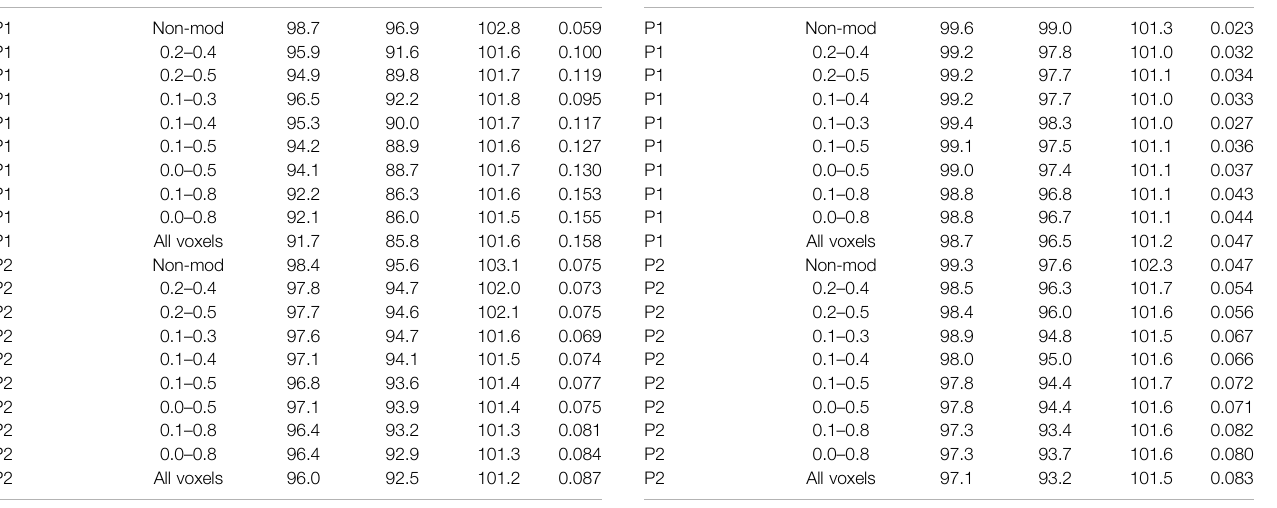
Frontiers in Physics |